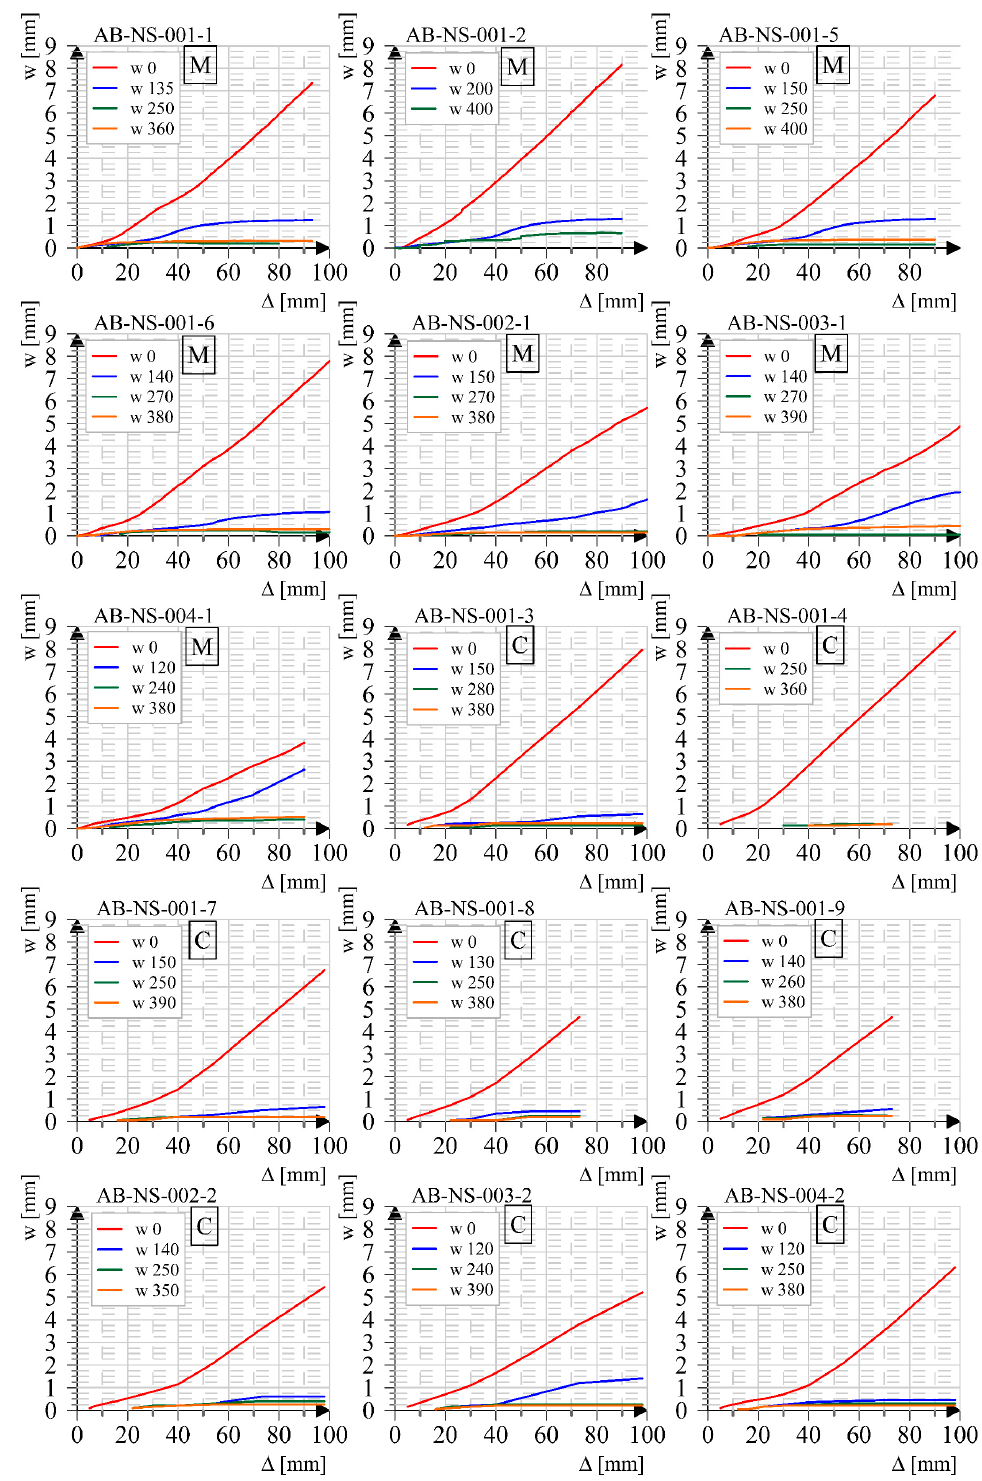
Figure 11. Crack width and position around plastic joint in relation to column top displacement.